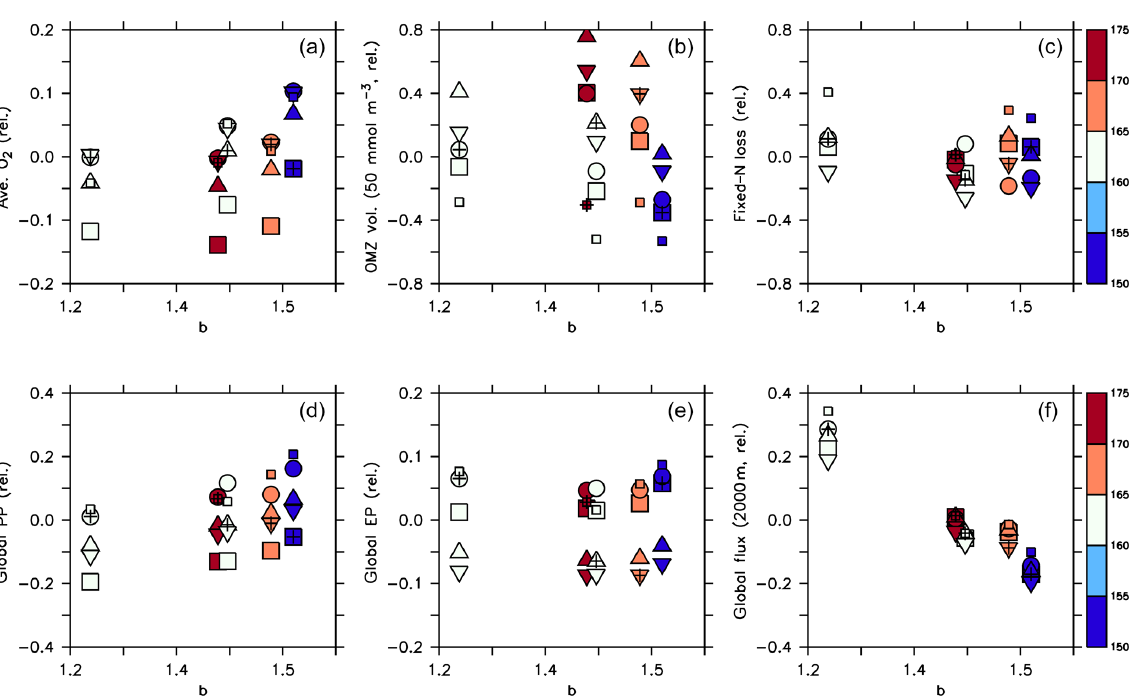
(colour scale). 2 : P